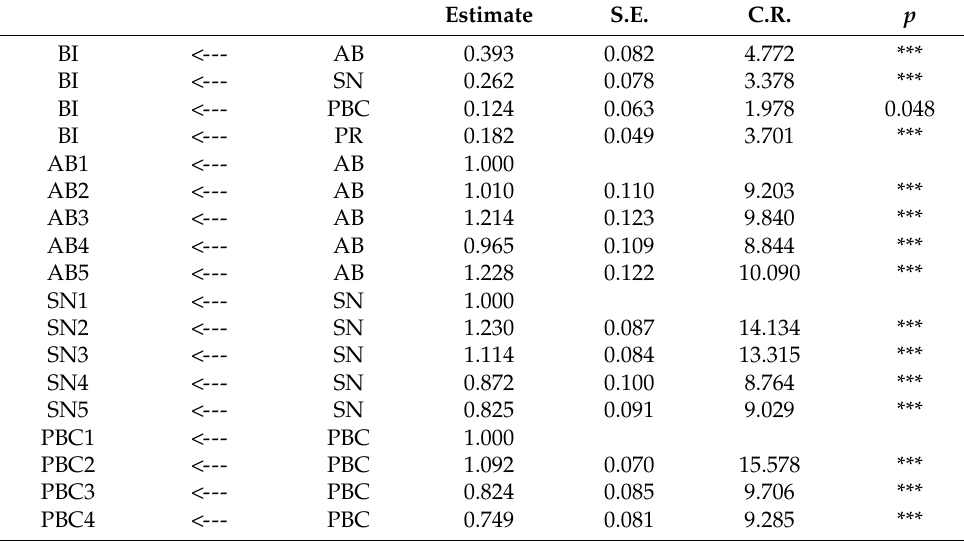
Table 6. Goodness-of-fit of the final model.